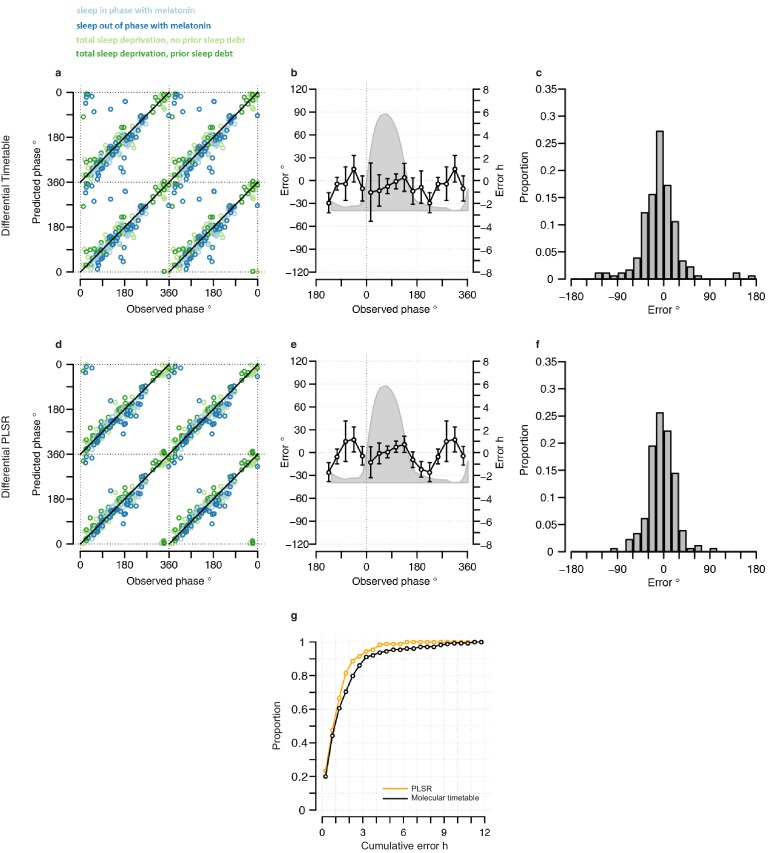
Performance of two-sample differential mRNA abundance-based models when used to predict the circadian phase in the validation set.(a and d) Predicted circadian phase of a blood sample vs. the observed circadian melatonin phase for each sample in the validation set for the two-sample differential molecular timetable model (a) and the two-sample differential PLSR-based model (d). Data are double-plotted. (b and e) Average (mean) error and 95% confidence intervals of the mean error per 30o, that is, 120 min, for each 30° circadian phase bins across the circadian cycle, for each of the models. The grey area plot represents the average melatonin profile. (c and f) Frequency distribution of errors. Errors were sorted into 15o, that is, 60 min bins, for each model. For each of the models, the mode of the distribution is near 0, but the width of the distribution varies across models. (g) Performance of the differential PLSR (orange), and the differential molecular timetable method (black) quantified by proportion of samples vs. cumulative error. Data source file Figure 4—source data 1.DOI:
http://dx.doi.org/10.7554/eLife.20214.01710.7554/eLife.20214.018Figure 4—source data 1.Source data file for generating panels in Figure 4.